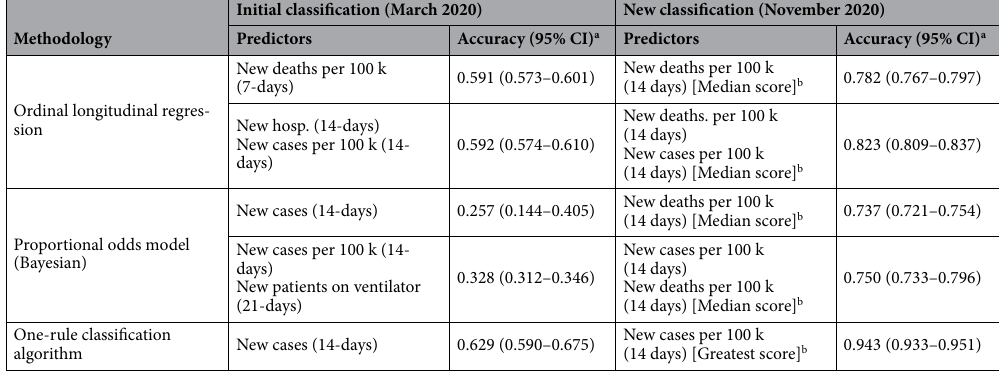
Table 2. Summary of accuracy for best fitting predictors across the three models considered. a Refers to total